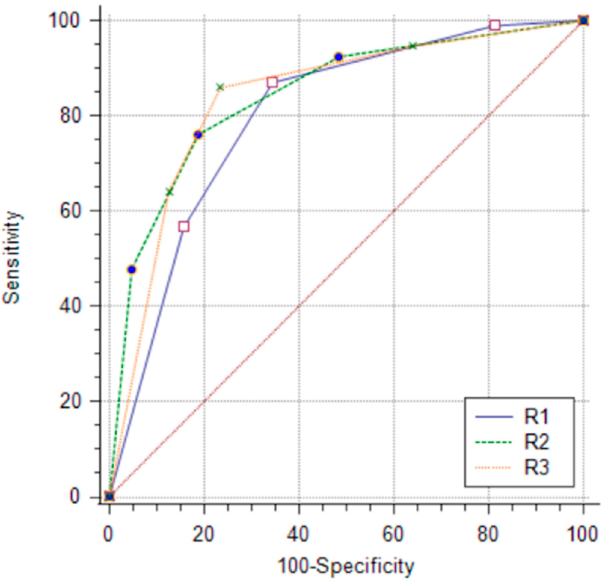
Figure 2. Comparison of ROC curves. Mean sensitivity was 95.4% and NPV was 82.2% using a cut-off for the enhancement intensity grade > 0 (Table 2). Using this cutoff, the mean negative likelihood ratio was 0.12. This value allowed the potential exclusion of breast malignancy, achieving BI-RADS 3 benchmarks of a less than 2% malignancy rate up to pre-test probabilities of 18%. Using the cutoff of > 0, mean specificity was 35.4% and PPV was 68.5% (Table 2). Table 2. Diagnostic performance of CEM enhancement intensity for all readers.